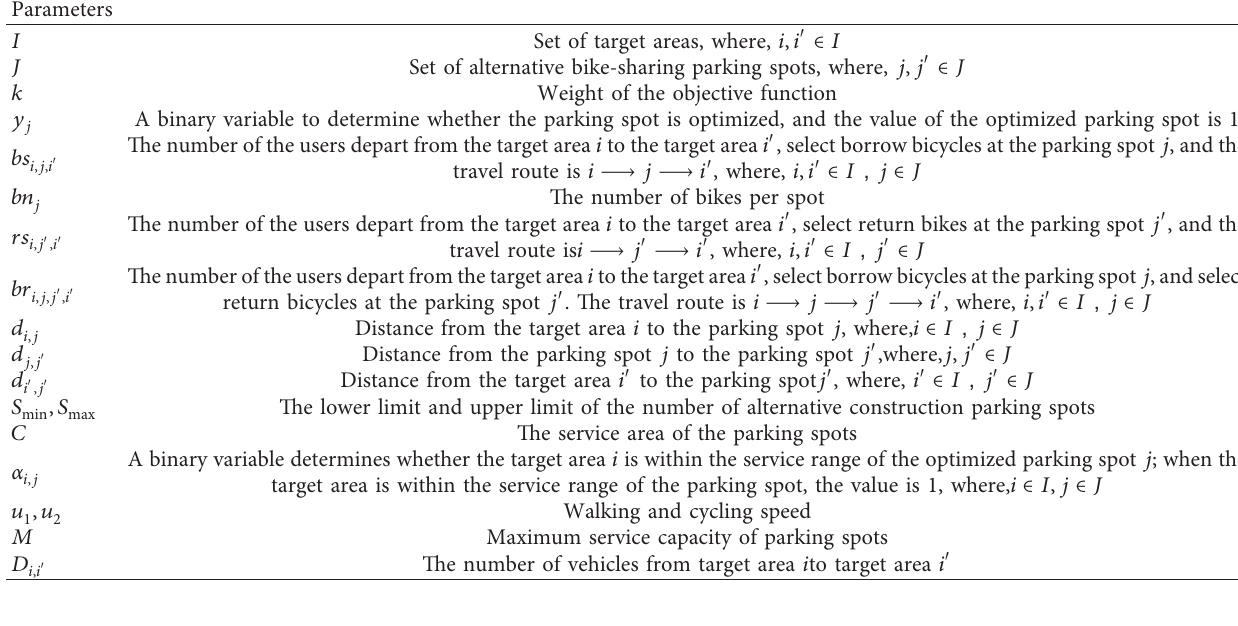
Table 1: Model parameter symbols